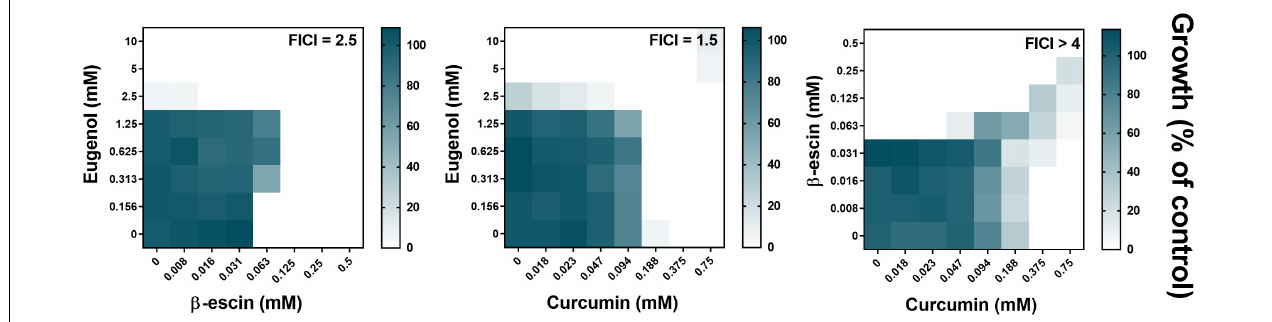
FIGURE 1 | Checkerboard assays of combinatorial growth effects of eugenol, β -escin, and curcumin in S. cerevisiae . Assays were performed according to the EUCAST procedure in YPD broth with S. cerevisiae W303 at the indicated concentrations of eugenol, β -escin, and curcumin. Growth values (scale to the right) represent means from three independent experiments, calculated as percentages of growth (OD 600 ) with the NPs relative to the minus-NP control. FICI, fractional inhibitory concentration index, calculated from data after 24 h growth at 30 ◦ C; growth values < 5% were assigned as no-growth (Hsieh et al., 1993). Corresponding data for S. cerevisiae BY4743 are shown in Supplementary Figure 1